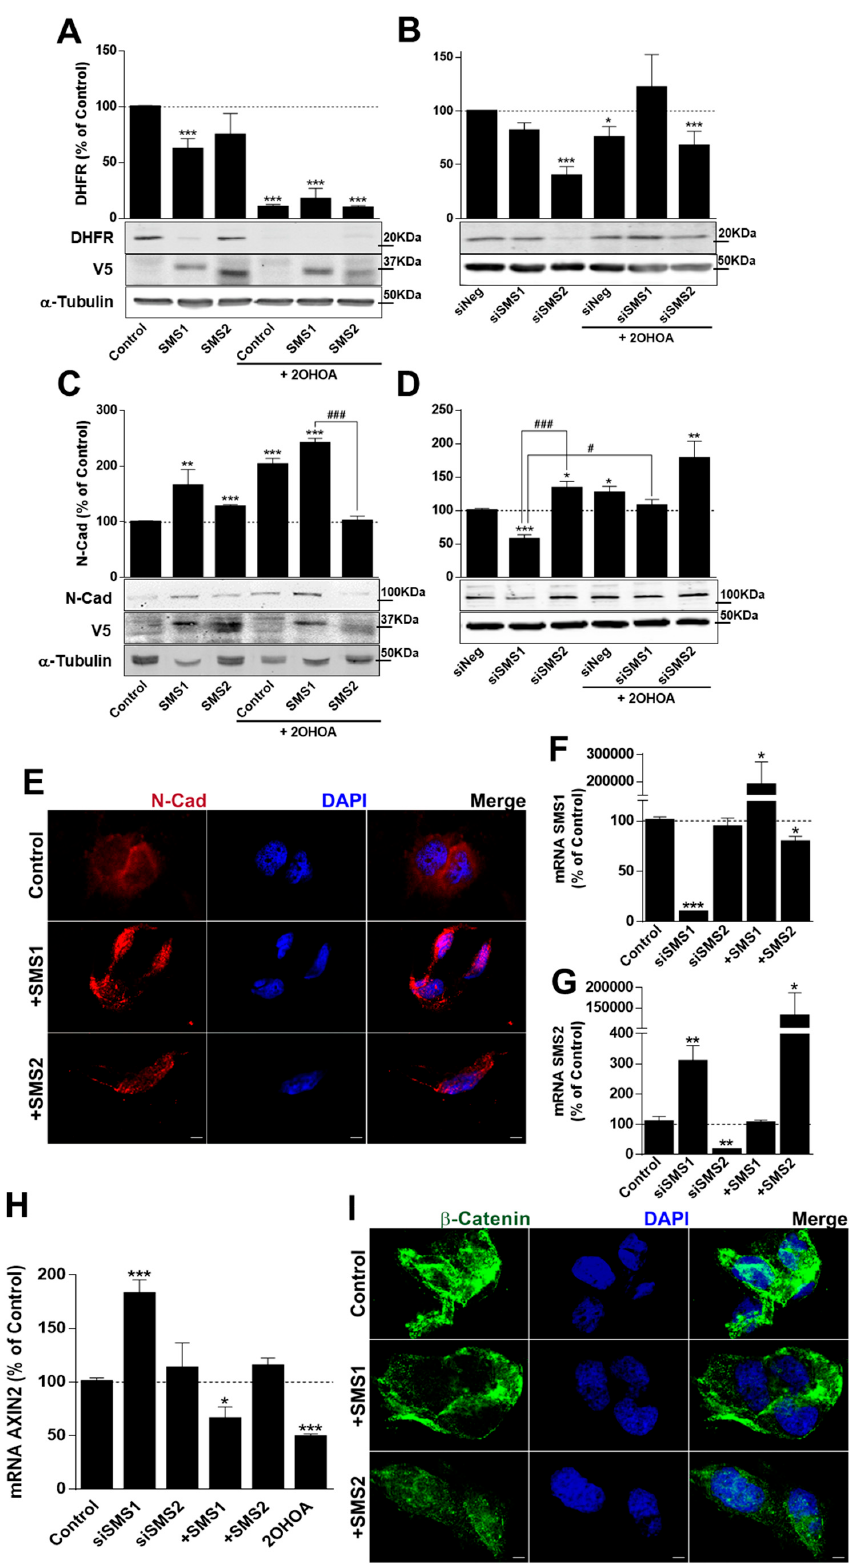
Figure 5. SMSs overexpression and 2OHOA effect on Proliferation and Differentiation in U118 cells. DHFR levels were determined by immunoblotting in U118 cells ( A ) overexpressing SMS1 or SMS2 (Tet-On Inducible Espression System) 72 h after doxycycline administration (1 µ g/mL to induce overexpression),